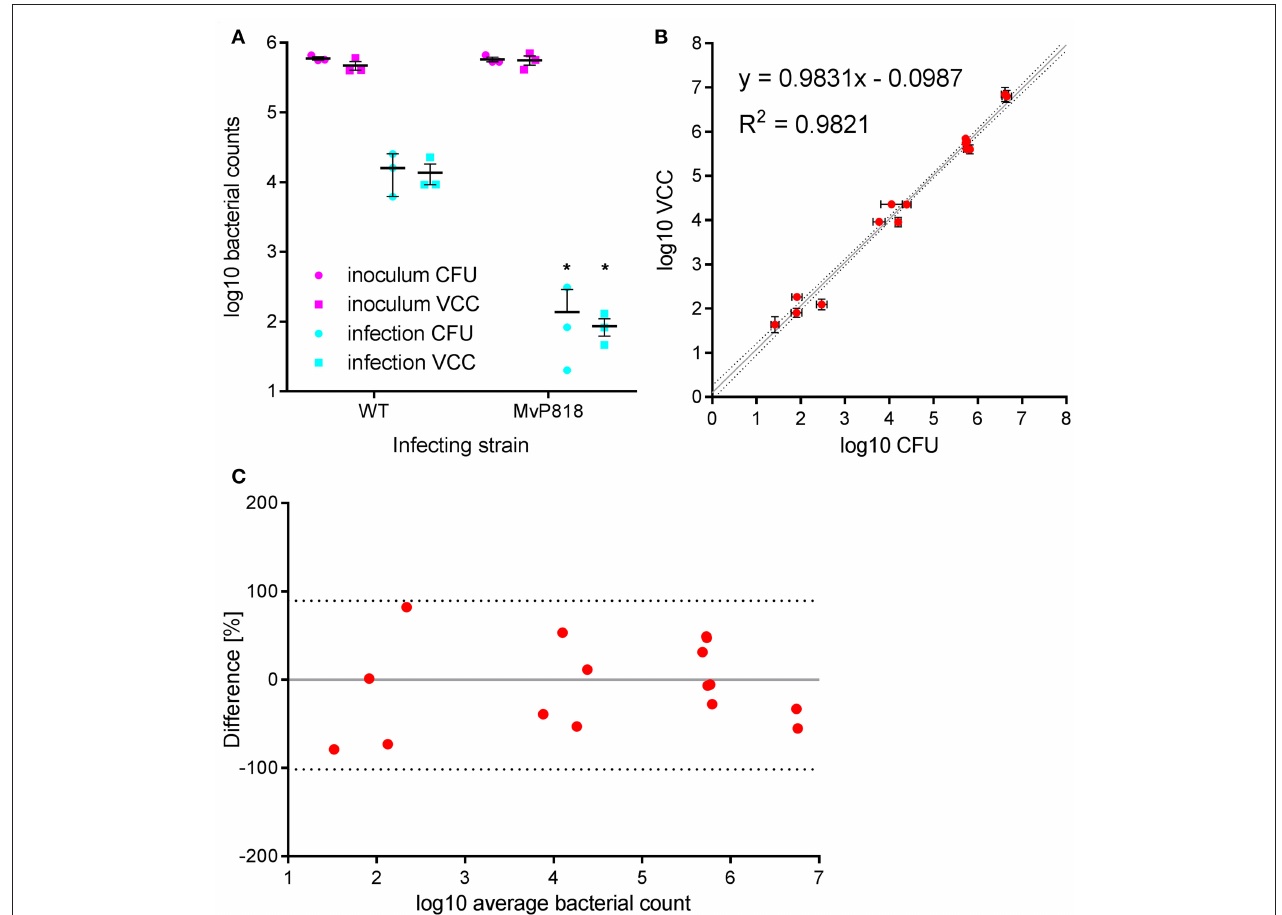
FIGURE 2 | Salmonella invasion of HeLa cells was used to evaluate VCC against CFU counting on solid agar in a direct side-by-side comparison. (A) Bacterial numbers in the inoculum (magenta) and intracellular bacteria recovered after 1h of infection (cyan) with wild-type (WT) or a T3SS-1 deficient Salmonella strain (MvP818) at an MOI of 100 from three independent experiments done in triplicates including means and SD are depicted. Statistical analysis by Student’s t -test demonstrates that mutant MvP818 is highly attenuated compared to WT using both enumeration methods. * P < 0.05 (B) Samples from four independent experiments enumerated with both methods are shown with SD indicated separately for VCC and CFU counting. The coefficient of determination ( R 2 ) is given for the correlation of both methods. Dotted black lines indicate the 95% confidence interval of the linear regression (gray line). (C) The data shown in (B) were plotted in a Bland-Altman diagram. Here, the mean of the corresponding bacterial counts determined with both methods was used as reference (0, gray line). The red dots represent the relative difference of the CFU counts compared to VCC by calculating 100*(CFU-VCC)/average. The 95% limits of agreement (dashed black lines) are at − 101.6 and 89.4%,